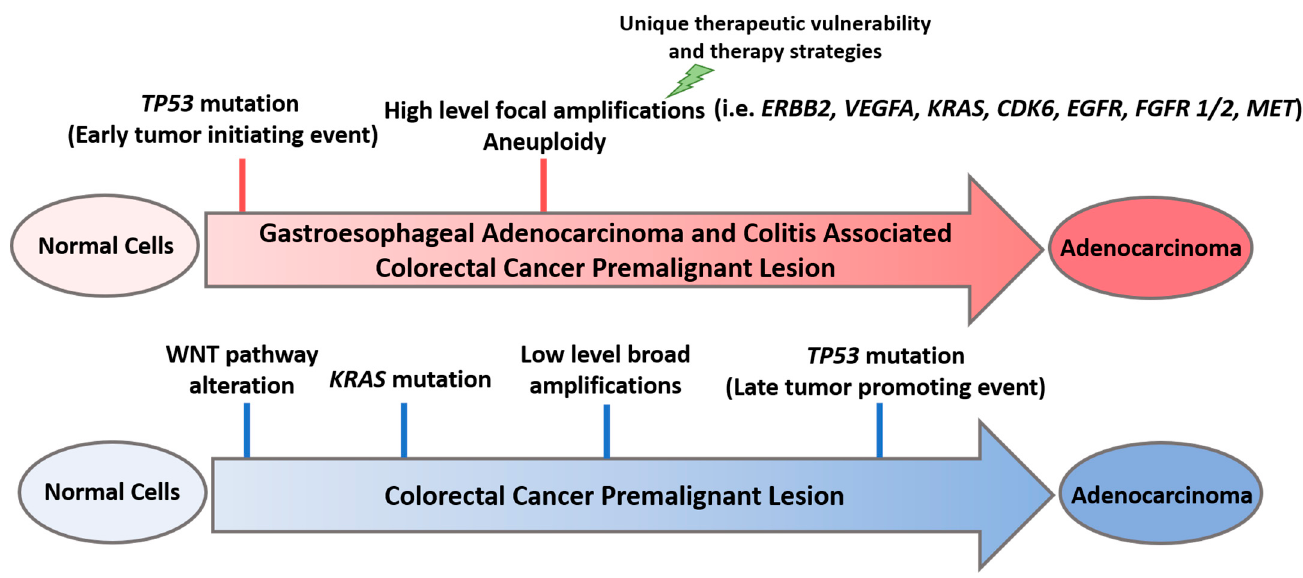
Figure 1. Early TP53 mutations and high-level focal amplifications in gastroesophageal (GE) adenocarcinoma and colitis-associated colorectal cancer (CAC) premalignant lesion, as opposed to late TP53 mutations and low-level broad amplifications and mutations in colorectal cancer (CRC) premalignant lesion. ERBB2: Erb-B2 receptor tyrosine kinase 2; VEGFA : vascular endothelial growth factor A; KRAS: Kirsten rat sarcoma; CDK6 : cyclin dependent kinase 6; EGFR : epidermal growth factor receptor; FGFR1/2 : fibroblast growth factor receptor 1/2; MET : mesenchymal epithelial transition factor.